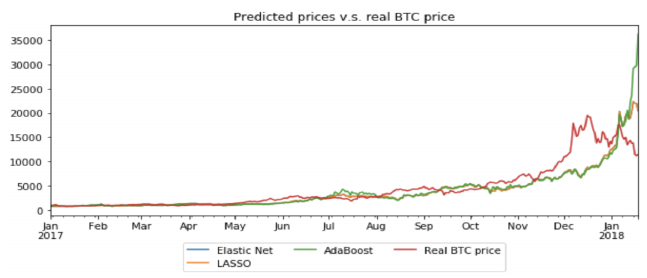
Figure 11: Predicted price vs. Real BTC price (predicting 30-day returns)